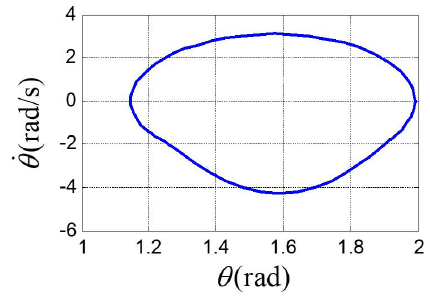
Figure 9. The stable orbit of the variable θ ( t )